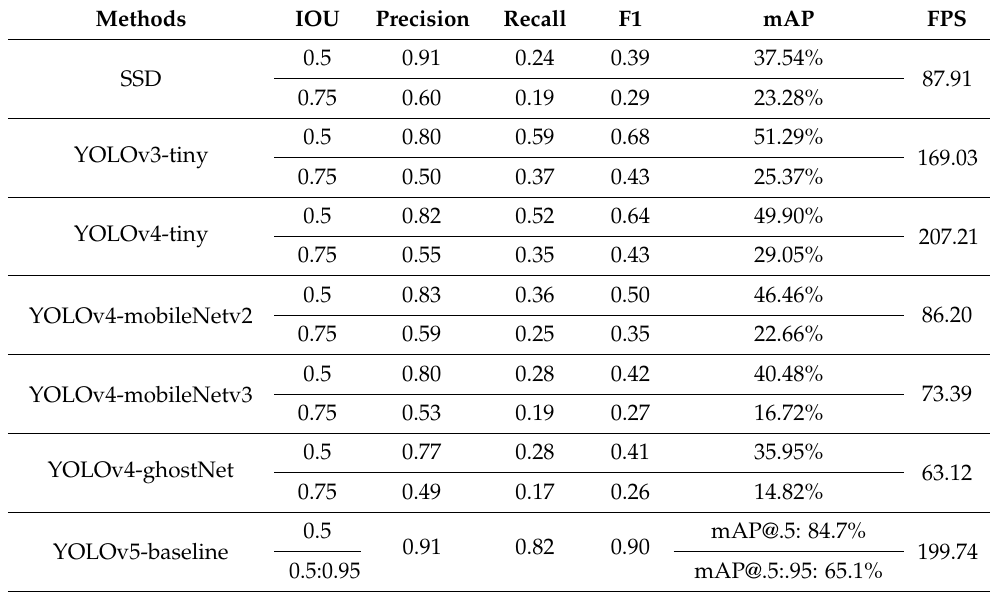
Table 5. Comparison of evaluation indicators under the original